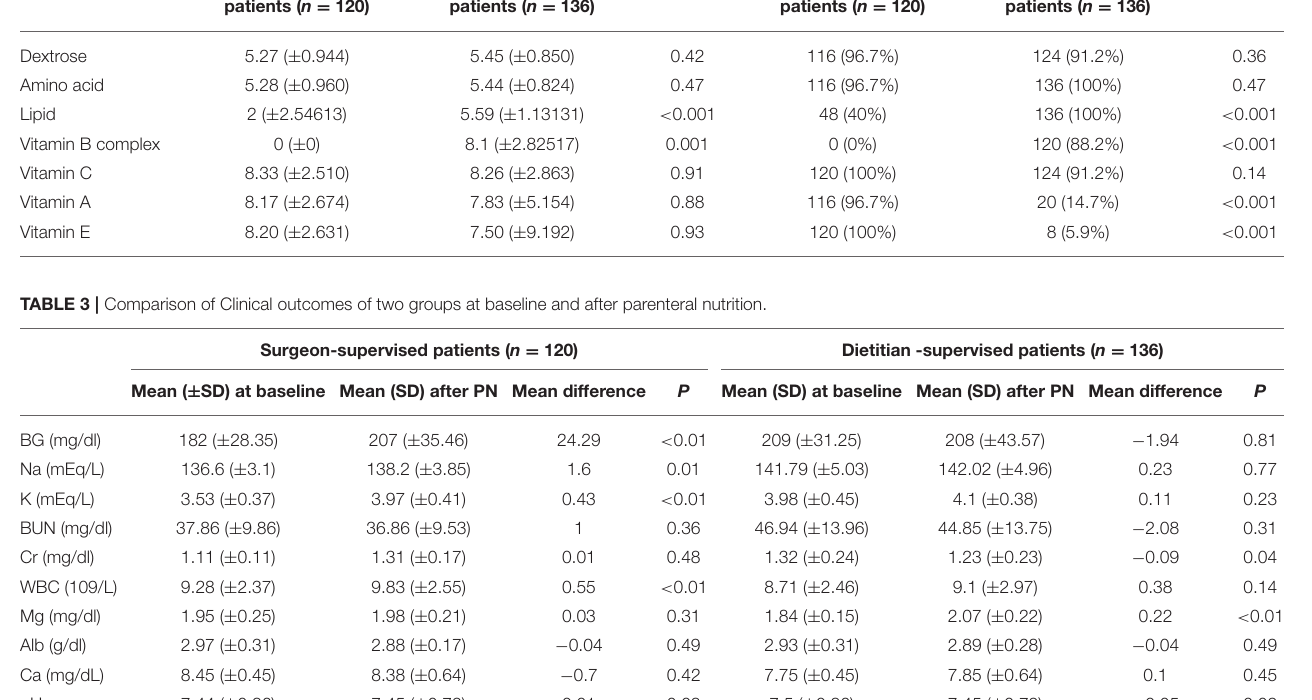
TABLE 2 | Average number of days to receive nutrients and the percentages of the patients who received nutrients among patients under surgeon and dietitian recommendations. Number of days to receive nutrients